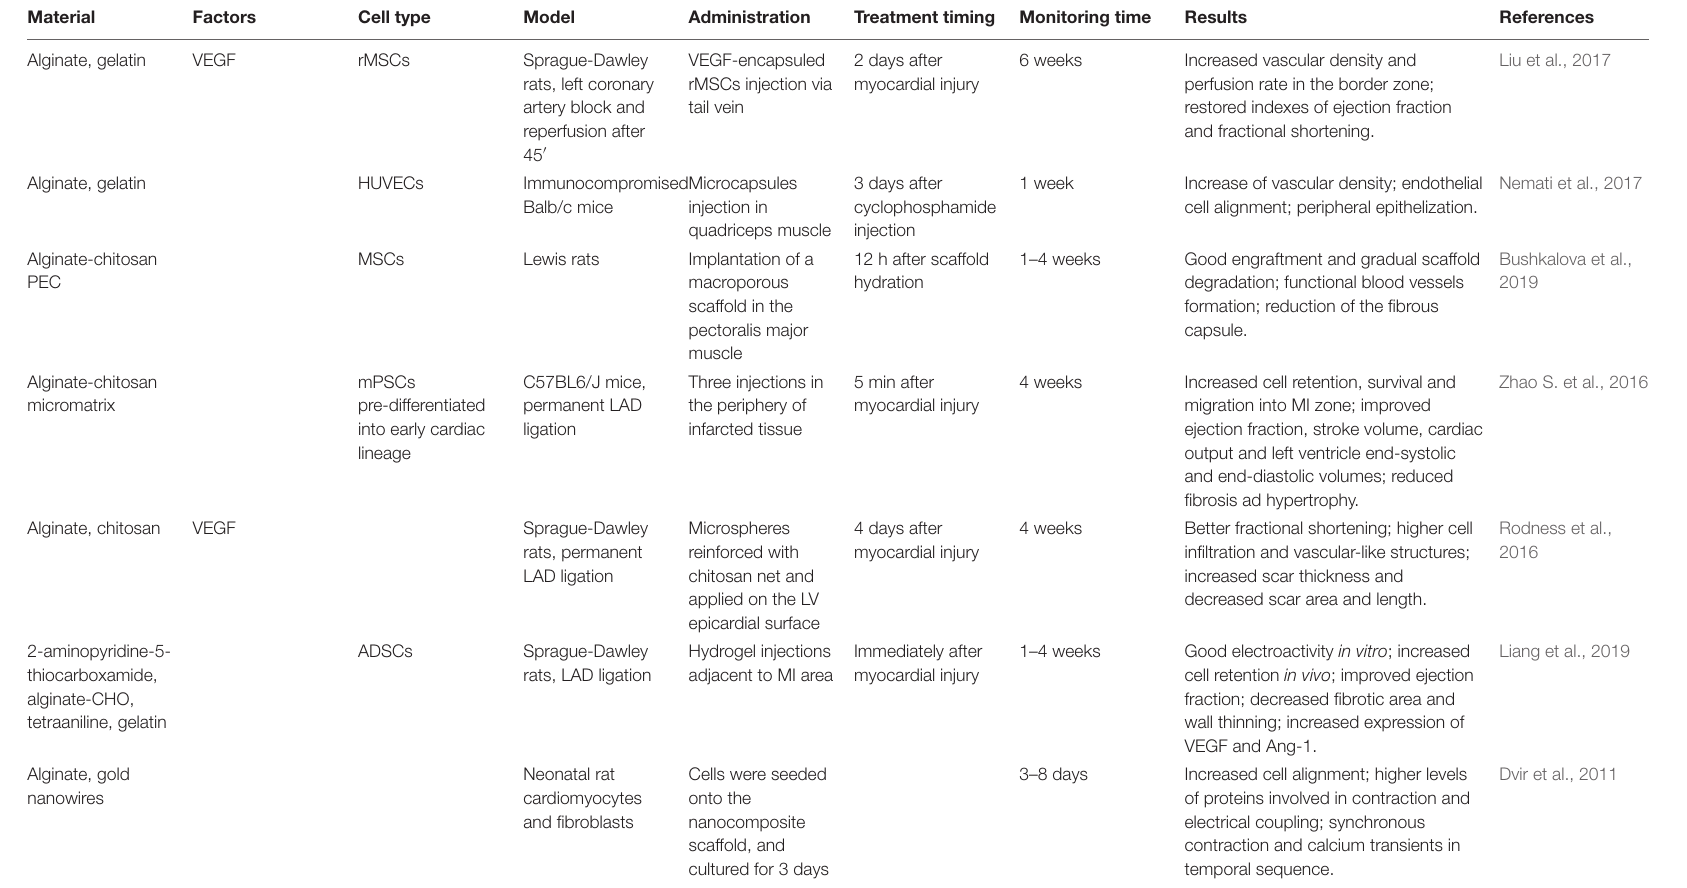
TABLE 1 | Promising alginate-based systems in cardiac